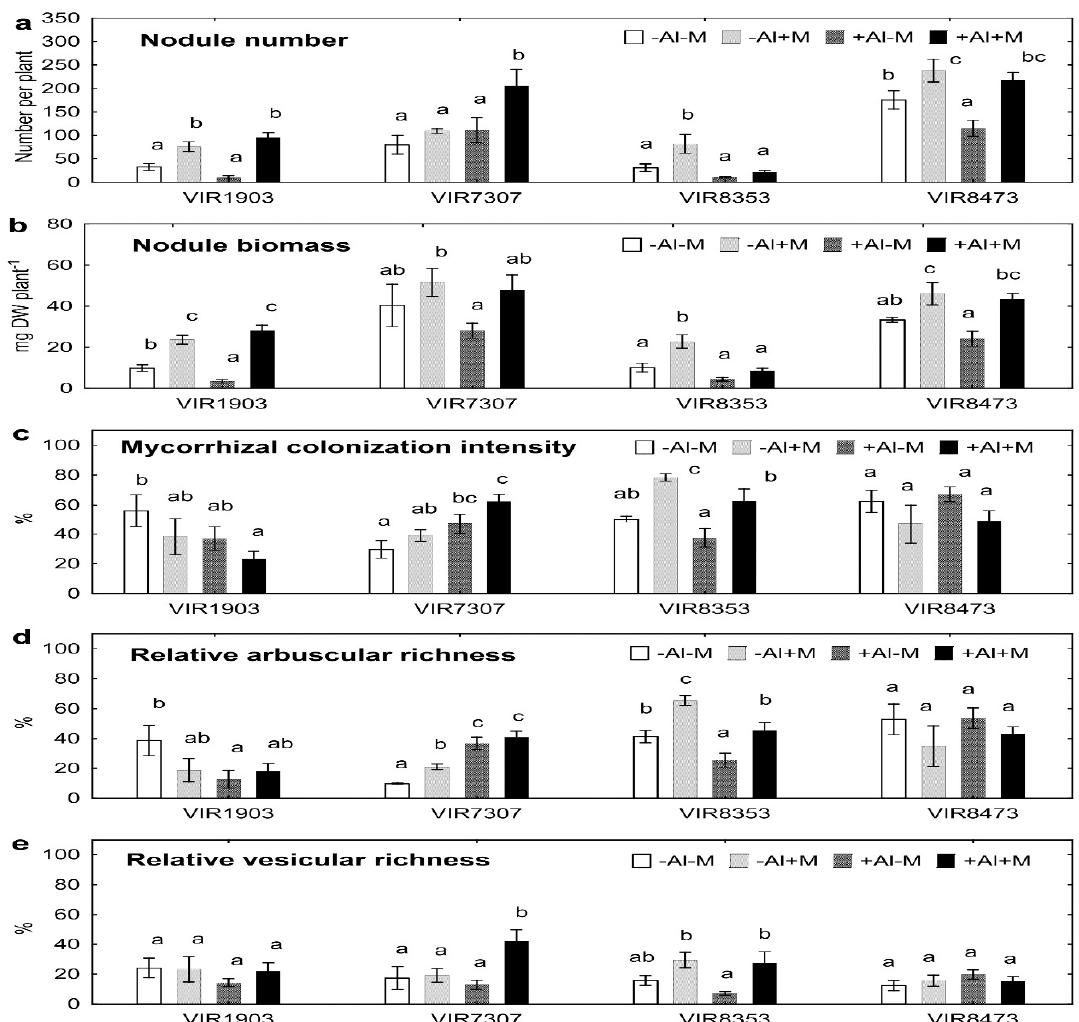
Figure 2. Nodule number ( a ), nodule biomass ( b ), root colonization intensity by mycorrhizal fungi ( c ), relative arbuscular richness ( d ) and relative vesicular richness ( e ) of pea genotypes VIR1903, VIR7307, VIR8353 and VIR8473 inoculated with microbial consortium. See details in the legend to Figure 1.